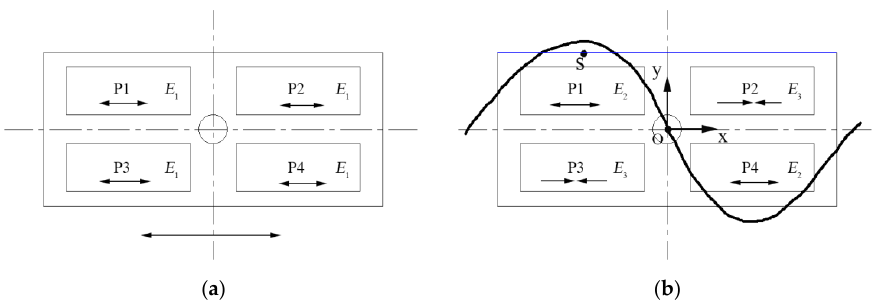
Figure 3. Vibration characteristics of the traveling wave vibrator under different vibration modes: ( a ) Longitudinal mode; ( b ) Bending mode. The longitudinal and bending modes provide horizontal and vertical deformations,